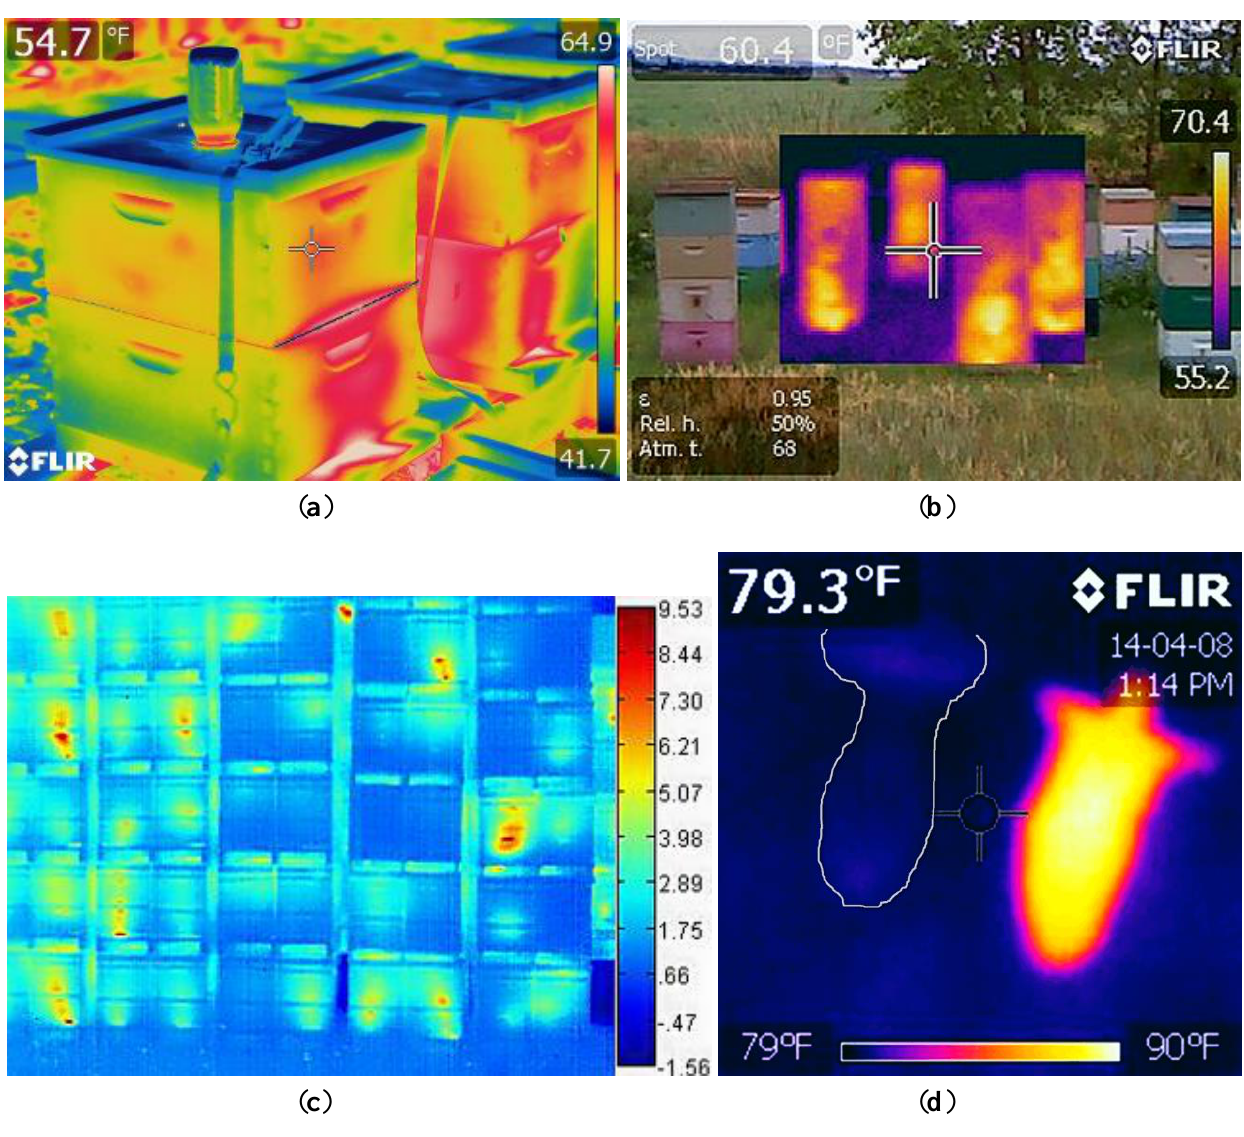
Figure 12. ( a ) Extreme high resolution (307,200 radiometric pixels) image of two bee colonies with feeder on nearest hive; ( b ) Picture in picture, high resolution, (76,800 radiometric pixels); MSX technology fuses infrared and visible light images; ( c ) Moderate resolution (19,200 radiometric pixels); thermal image only of pallets of bee hives stacked in a wintering shed; ( d ) Moderate resolution (19,200 radiometric pixels) image of two queen cells removed from an incubator and left at room temperature for five minutes. Cell on left has stillborn queen; cell on right has live